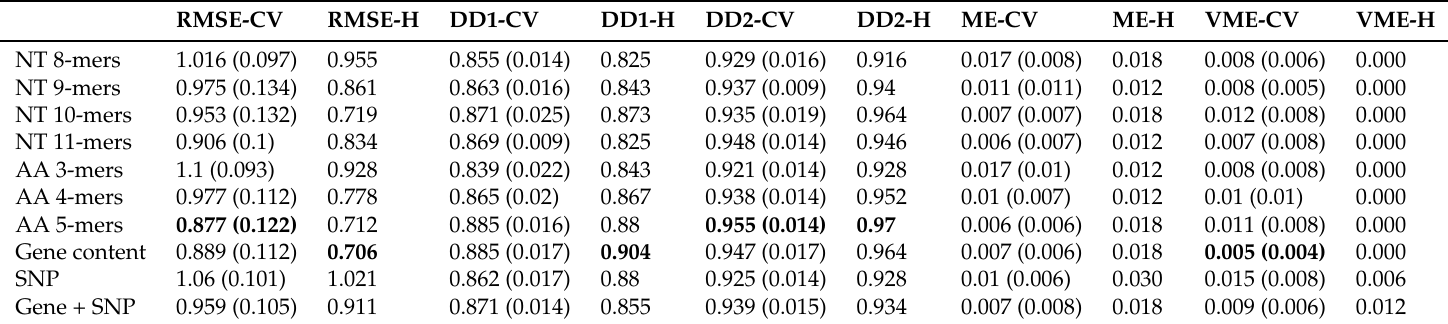
Table A41. K. pneumoniae –ceftazidime.